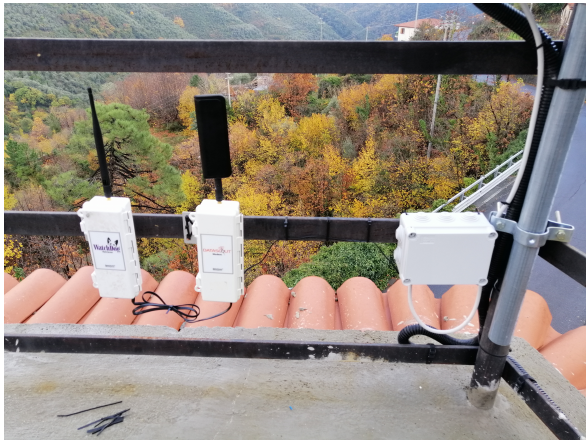
Figure 3. Retriever and Modem positioned in